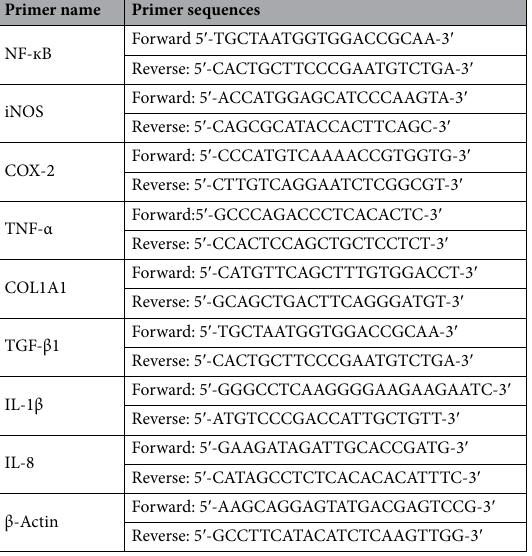
Table 1. Forward and reverse primer sequences used in the qRT-PCR. NF-κB nuclear factor-kappa B, iNOS inducible nitric oxide synthase, COX-2 cyclooxygenase -2, TNF-α tumor necrosis factor-α, COL1A1 collagen type I alpha one chain, TGF-β1 transforming growth factor-β1, IL